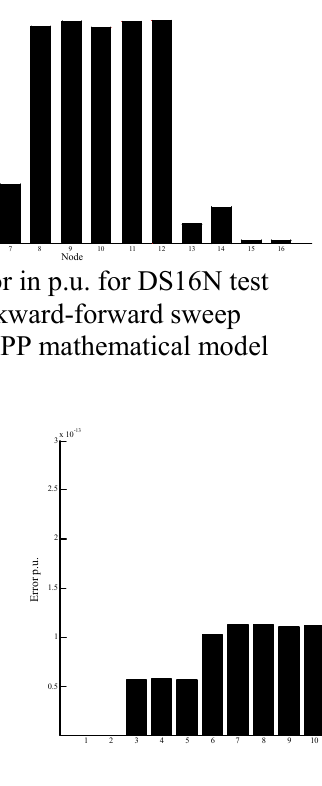
Fig. 3. Voltages error in p.u. for DS23N test system between backward-forward sweep algorithm and EVs-IPP mathematical